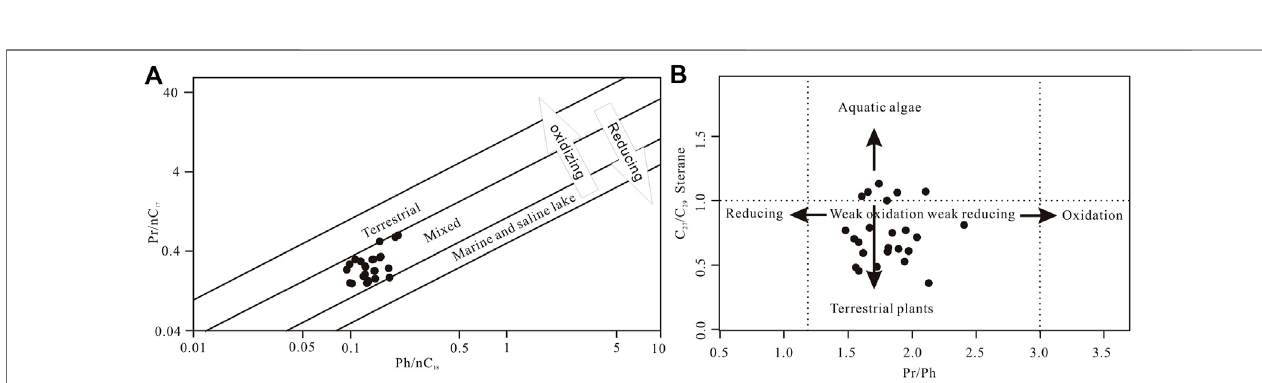
FIGURE9| Cross plots: (A) Q1versusTOC; (B) Q2versusTOC; (C) QversusTOC;and (D) RversusHI,givinganindicationfortheoriginsoforganicmatterinthe Chang-7 shale in the study area.